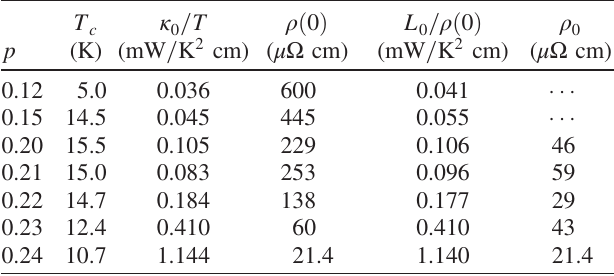
n ≃ p at p ¼ 0 . 20 < p ⋆ [19], in good agreement with H YBCO [11].